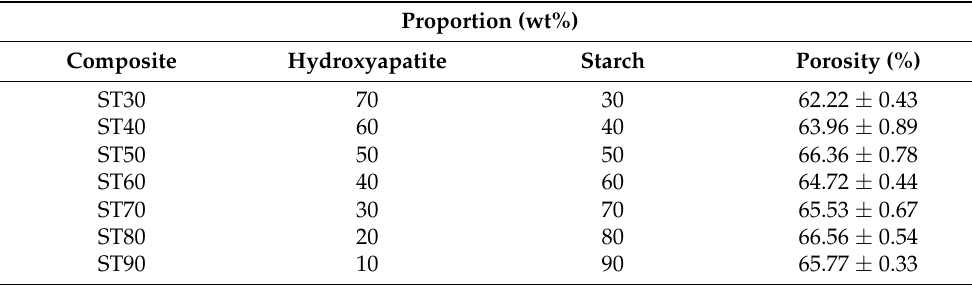
Table 1. Composition and porosity of the porous HAp/ST